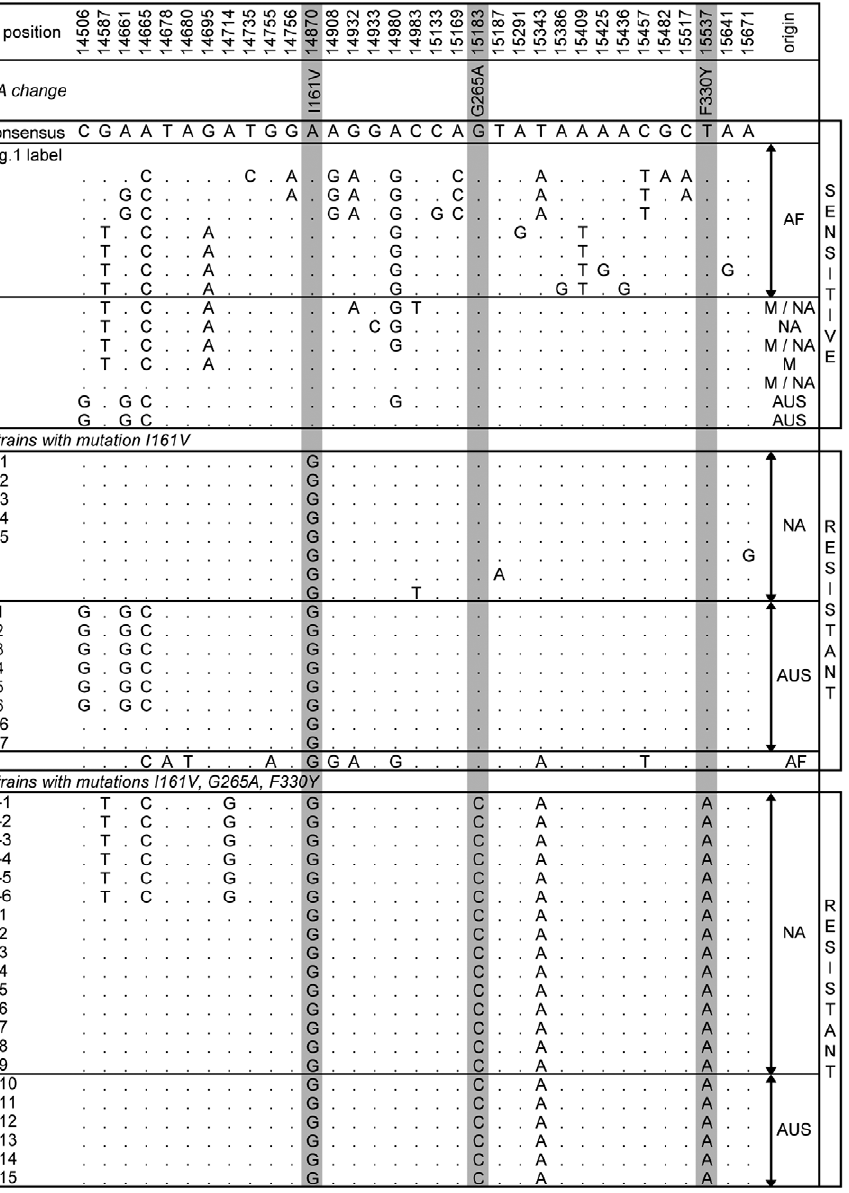
Figure 2. Soft sweeps at Ace . The table shows segregating sites within the 1.5-kb region of Ace . Each strain is named according to the corresponding letter in Figure 1. When multiple strains shared the same haplotype, they were named with the same letter but with different numbers ( i.e. w-1, w-2, w-3). For the names and origins of the strains refer to Table S1 and Table S2. The nucleotide position and the consensus sequence at the top of the table correspond to the y 1 ; cn 1 bw 1 sp 1 strain. The positions of the three resistant mutations are shaded. The table shows all sensitive haplotypes observed more than once as well as all haplotypes containing the resistant mutation at the first site (I161V) and the ones that contain all three resistant mutations.